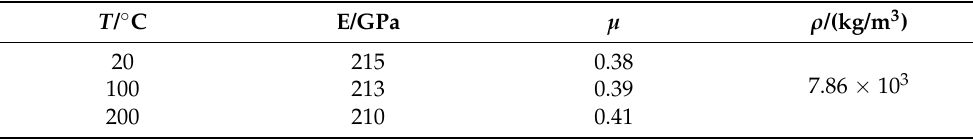
Table 1. Physical parameters of gears.